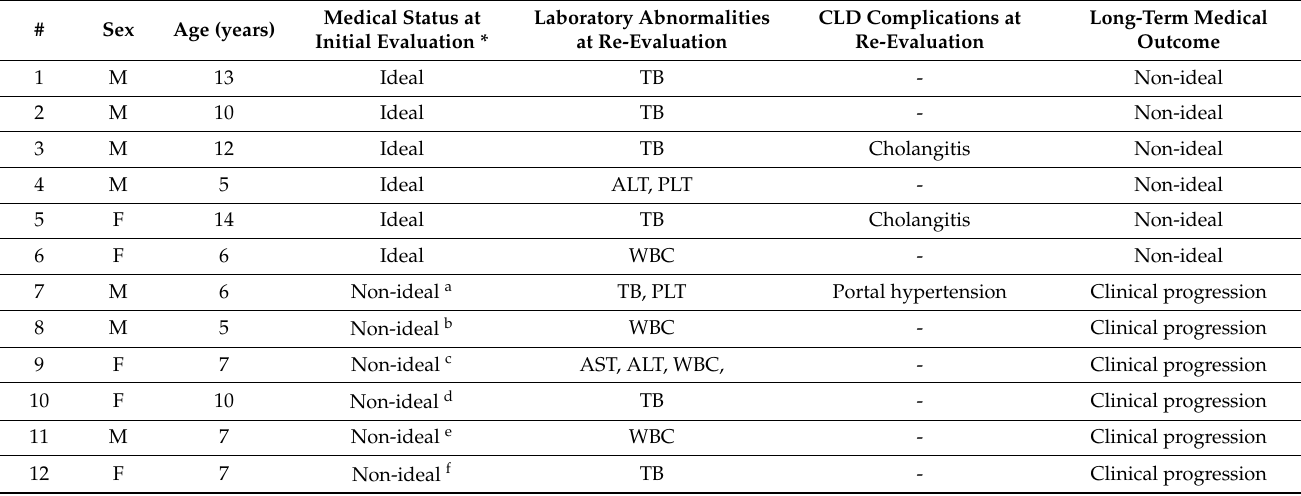
Table 2. Clinical results of non-stable patients (group 2).